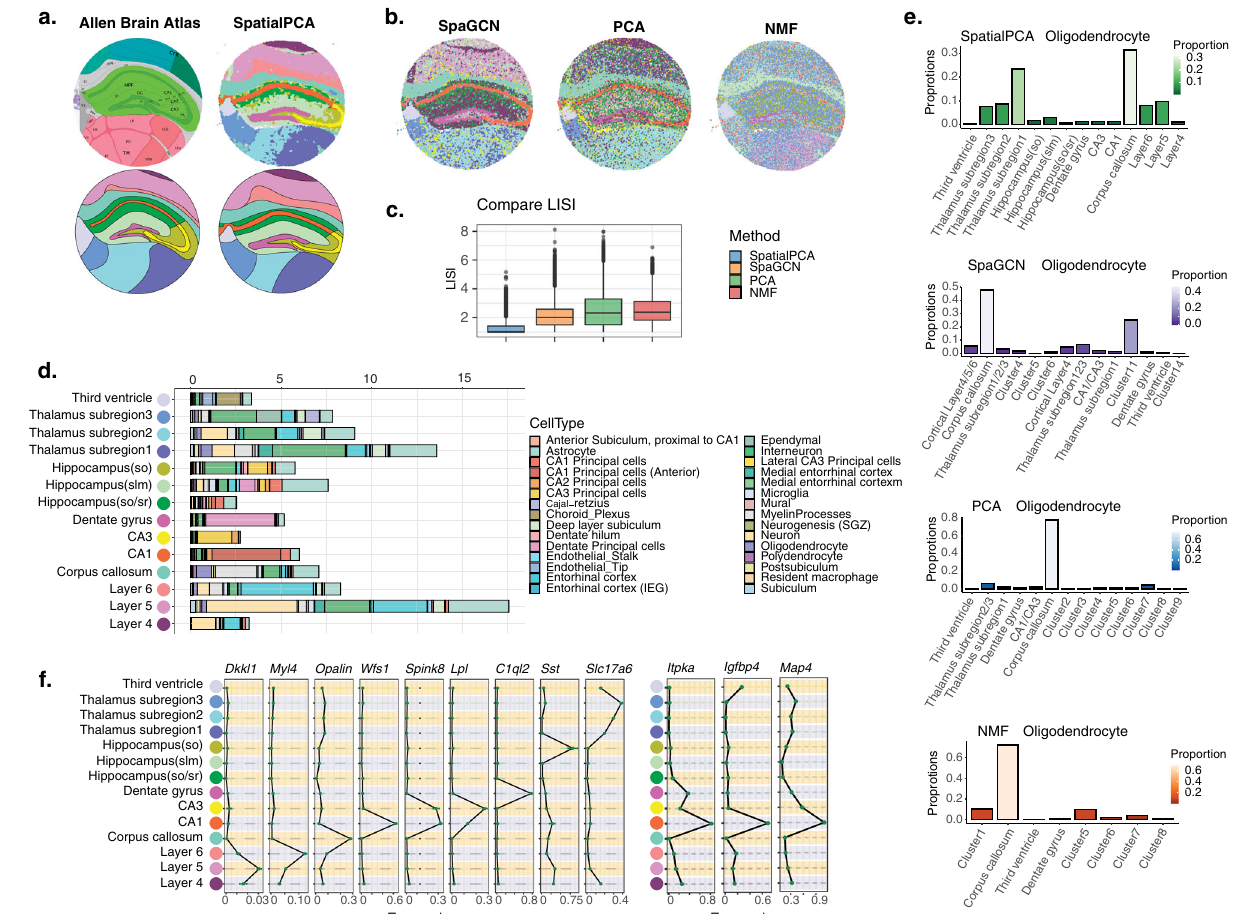
Fig. 4 | Analysis of the hippocampus data from Slide-seq V2. a Left panel: The structureofthemousehippocampus,withthemaintissueregionsannotated from Allen Brain Atlas. Right panel: SpatialPCA segregates tissue locations into distinct tissue regions. Lower panel: Tissue structures based on annotations from Allen Brain Atlas and spatial domains detected by SpatialPCA. The detected tissue regions were annotated based on their relative positions on the tissue and the enriched celltypesineachdetected tissue domain. b Clusteringof tissue locations based on the other methods. For SpaGCN, clusters were inferred directly by the software. For dimension reduction methods (PCA and NMF), clustering was per- formed based on the inferred low-dimensional components on spatially variable genes. c Clustering performance of different methods in obtaining smooth and